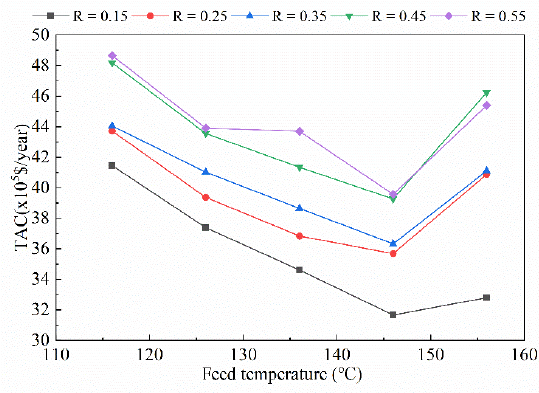
Figure 6. Effect of cold-to-hot feed ratio and hot feed temperature of sour water stripper on total annual cost of heat integration process.